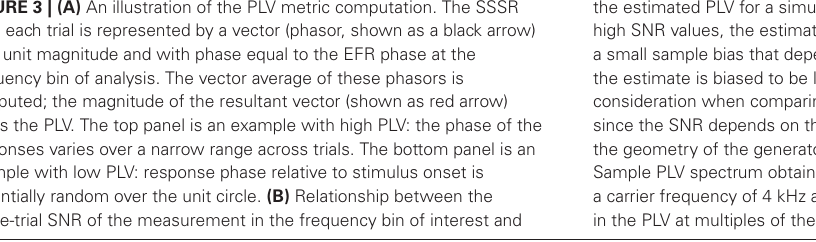
FIGURE 3 | (A) An illustration of the PLV metric computation. The SSSR from each trial is represented by a vector (phasor, shown as a black arrow) with unit magnitude and with phase equal to the EFR phase at the frequency bin of analysis. The vector average of these phasors is computed; the magnitude of the resultant vector (shown as red arrow) yields the PLV. The top panel is an example with high PLV: the phase of the responses varies over a narrow range across trials. The bottom panel is an example with low PLV: response phase relative to stimulus onset is essentially random over the unit circle. (B) Relationship between the single-trial SNR of the measurement in the frequency bin of interest and